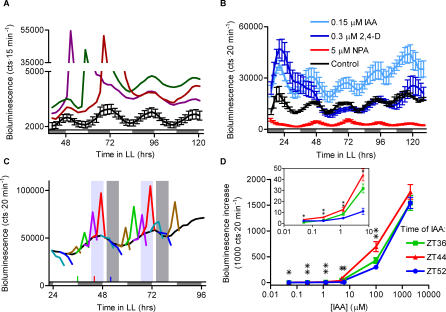
Native Auxin Signaling and Sensitivity to Exogenous Auxin Are Circadian Regulated(A) eDR5::LUC bioluminescence with standard error of the mean is shown for T1 plants in continuous light (black trace with error bars; n = 28; circadian and expression ≥5% above background). Data are also shown for eDR5::LUC T1 plants that were sprayed with 20 μM IAA at ZT47 (purple line), ZT55 (green line), and ZT65 (dark red line) (n = 32, 34, and 34; expression ≥5% above background prior to treatment). The y-axis has been split in order to better visualize both the circadian and the auxin-responsive expression of eDR5::LUC.(B) eDR5::LUC rhythms in the presence of exogenous auxins (IAA and 2,4-D) and an auxin transport inhibitor (NPA) are shown. Bioluminescence from the apex of each seedling was measured (n = 3–18).(C) Circadian gating of auxin sensitivity is presented. Groups of eDR5::LUC plants (n = 8) were treated with 0.15 μM IAA at 4-h intervals. Bioluminescence levels at 1 h prior to treatment and 1, 3, and 5 h after treatment are shown in various colors for each auxin application. Data from treated samples have been normalized such that the bioluminescence level of the pretreatment time point matches that of the control, shown in black (i.e., all values for a particular treatment have been divided by the pretreatment value and multiplied by the control value that corresponds to the pretreatment time point). The color-coded tick marks above the x-axis correspond to the times of auxin application data in Figure 4D. Areas shaded light- and dark-gray correspond to the 6-h periods in Figure 5A during which exogenous auxin promotes or has no effect, respectively, on hypocotyl elongation. (See Figure S5 for an alternate presentation of the data from Figure 4C, see Figure S6 for this data plotted adjacent to the data from Figure 5A.)(D) eDR5::LUC plants were sprayed with the indicated concentrations of IAA at different times of day as described for (C). Presented are the differences in bioluminescence 3 h after IAA treatment compared to the control plants. The lower range of doses is also shown as an inlay. One or two asterisks indicate that the response at ZT44 is significantly (p < 0.05) greater than the responses at one or both of the other time points, respectively. Datasets are color coded to match the tick marks above the x-axis in Figure 4C. (A–C) and (D) show representative data from two and three independent experiments each, respectively.